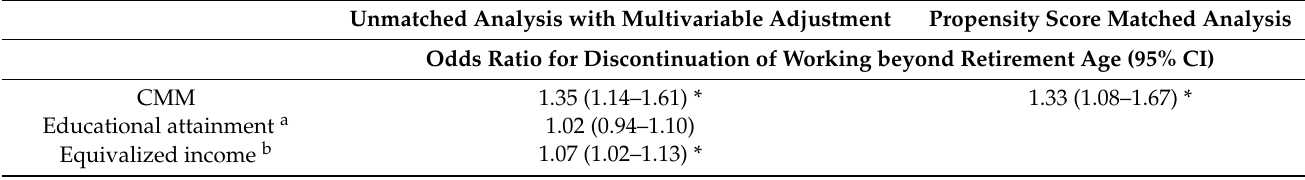
Table 4. Risk of discontinuation of working beyond retirement